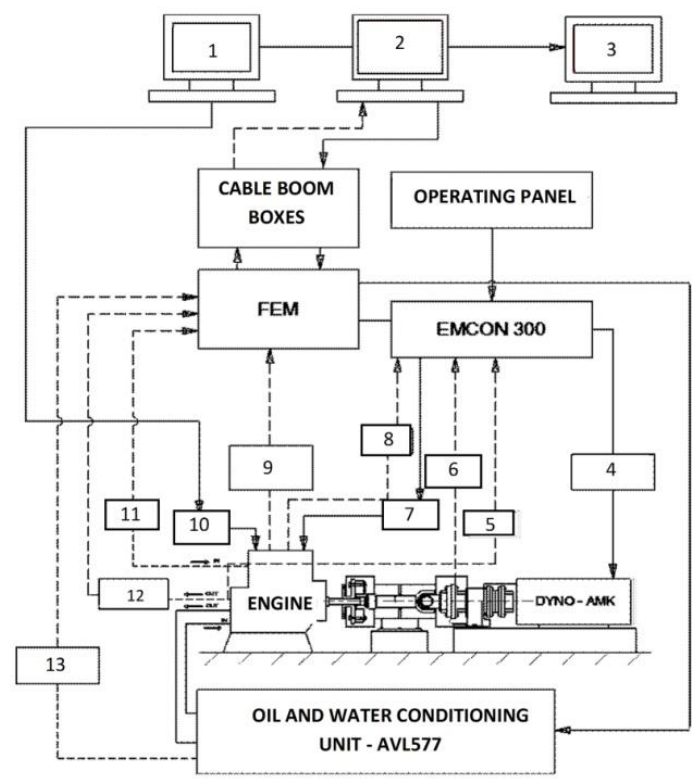
Figure 2. Diagram of a single-cylinder engine test strip. 1 INCA PC; 2 PUMA PC; 3 INDICATING PC; 4 DYNO torque control cabin; 5 Engine speed signal; 6 Engine torque; 7 Control throttle position signal; 8 Throttle position sensor; 9 Pressure and temperature sensor; 10 ECU; 11 Fuel balance; 12 Opacimater; 13 Temperature